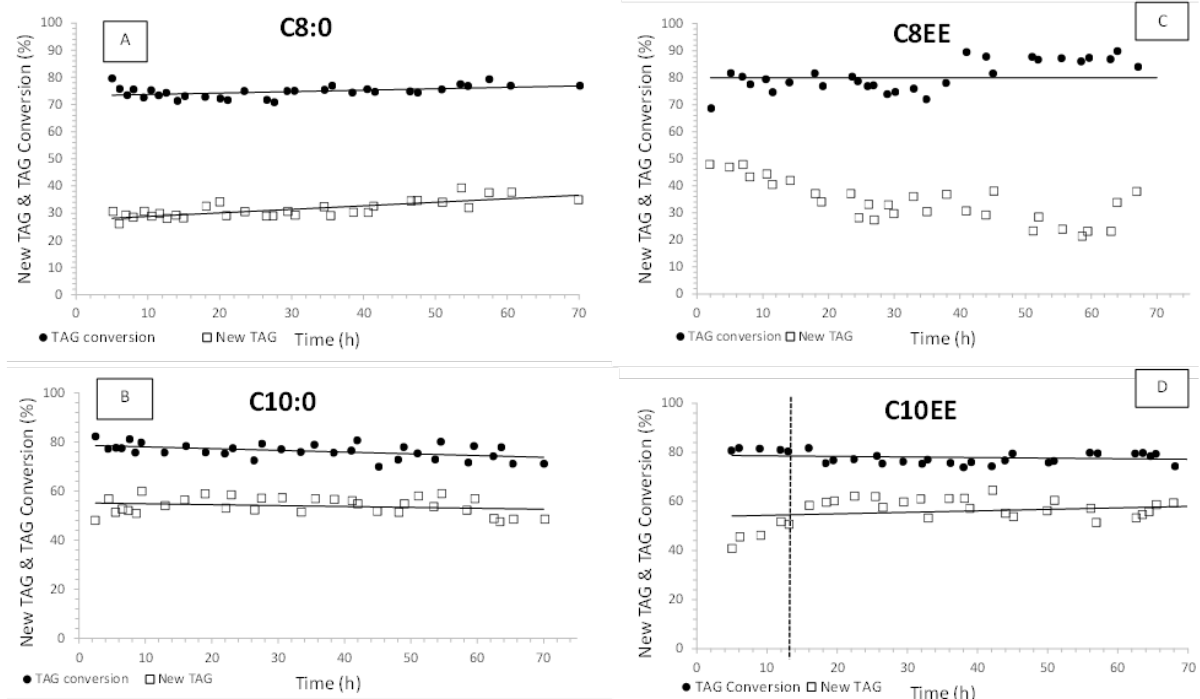
Figure 2. New TAG yield and TAG conversion along continuous acidolysis and interesterification reactions of ( A ) C8:0, ( B ) C10:0, ( C ) C8EE, and ( D ) C10EE, respectively, catalyzed by Lipozyme RM IM biocatalyst.